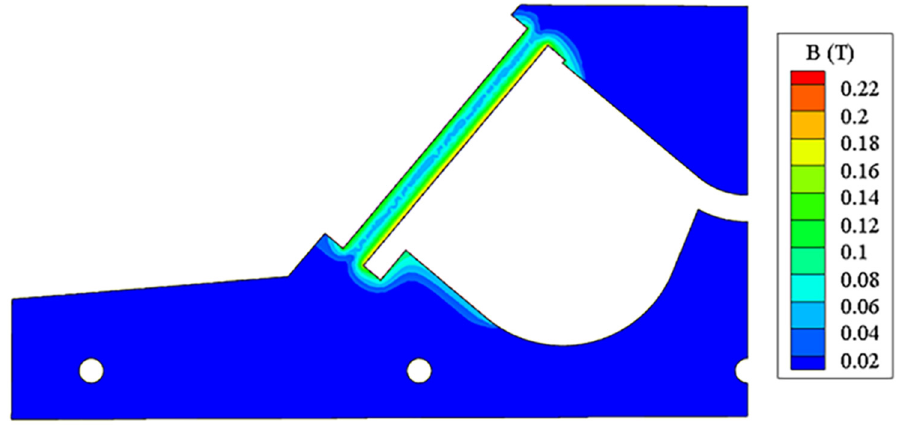
Figure 9. Magnetic field intensity distribution in tundish.